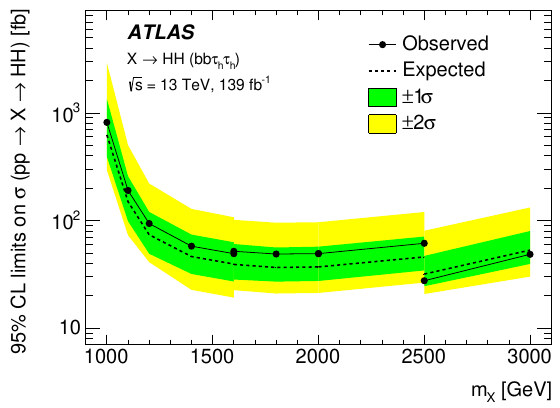
Figure 13. Expected and observed 95% CL upper limits on the production cross-section of a heavy, narrow, scalar resonance decaying into a pair of Higgs bosons ( X → HH ). The final state used in the search consists of a boosted b ¯ b pair and a boosted hadronically decaying τ + τ − pair, and the SM branching fractions of the Higgs boson are assumed. The ± 1 σ and ± 2 σ variations about the expected limit are indicated by the green and yellow bands,